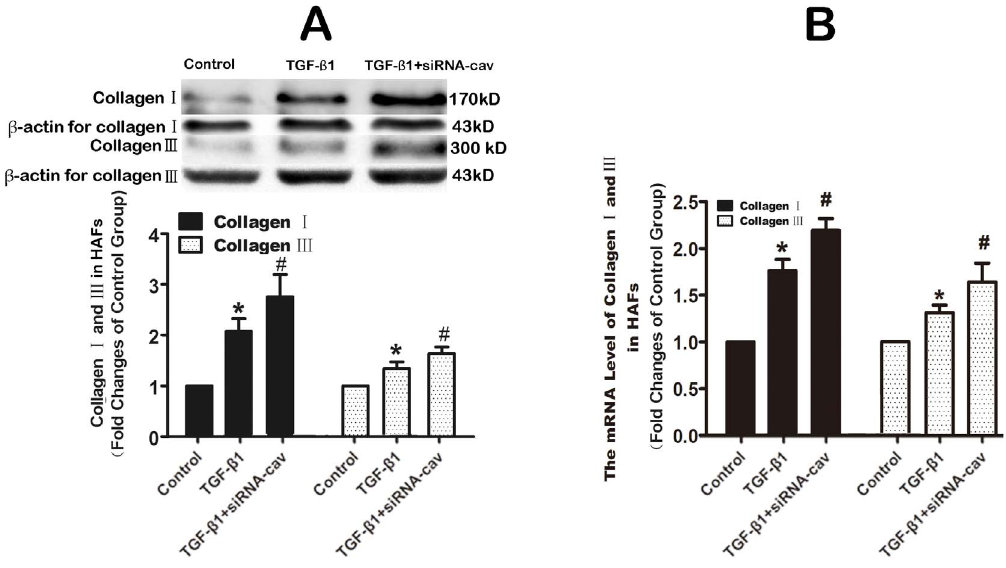
Figure 8. Downregulation of caveolin-1 increased the TGF- b 1-induced collagens production. HAFs in the siRNA-cav group were transfected with the caveolin-1 siRNA using Hiperfect transfection reagent following protocols provided by the manufacturer, and then HAFs were treated with 100 ng TGF- b 1 for 48 h. HAFs in TGF- b 1 group were only treated with 100 ng TGF- b 1 for 48 h for western blot or 24 h for qRT-PCR. Note that downregulation of caveolin-1 with the caveolin-1 siRNA increased the TGF- b 1-induced the mRNA level (B) and protein level (A) of collagen I and III production in HAFs. HAFs, human atrial fibroblasts. siRNA-Cav, the caveolin-1 siRNA. *P , 0.05 vs. control group. # P , 0.05 vs. TGF- b 1 group. n=3 per group; measurement in triplicate for each single experiment.